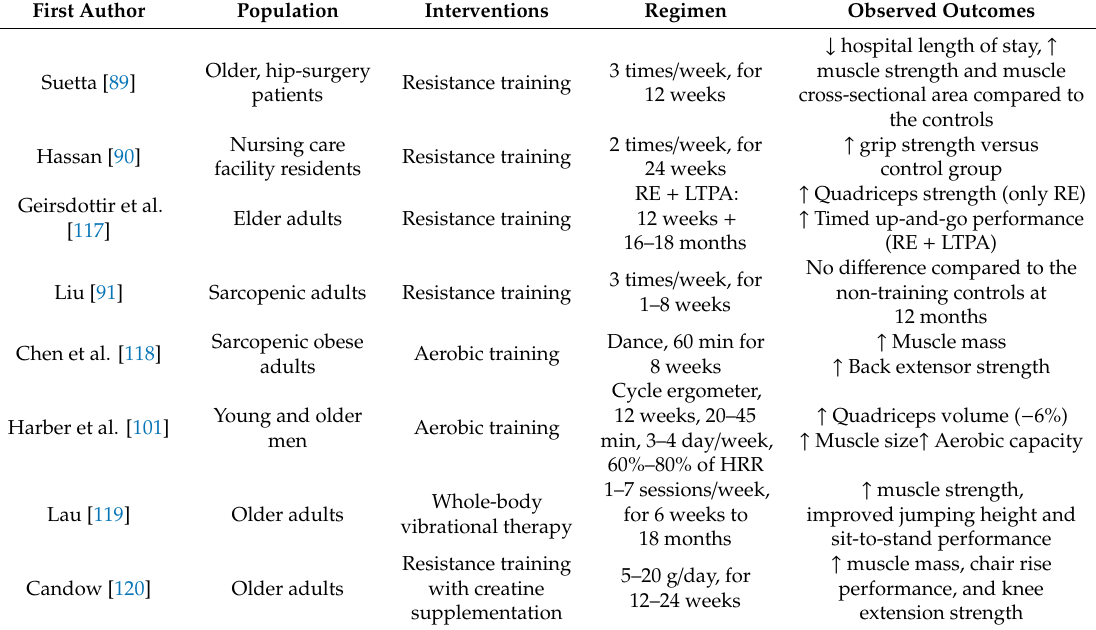
Impact of resistance training, aerobic training, and whole-body vibrational therapy in